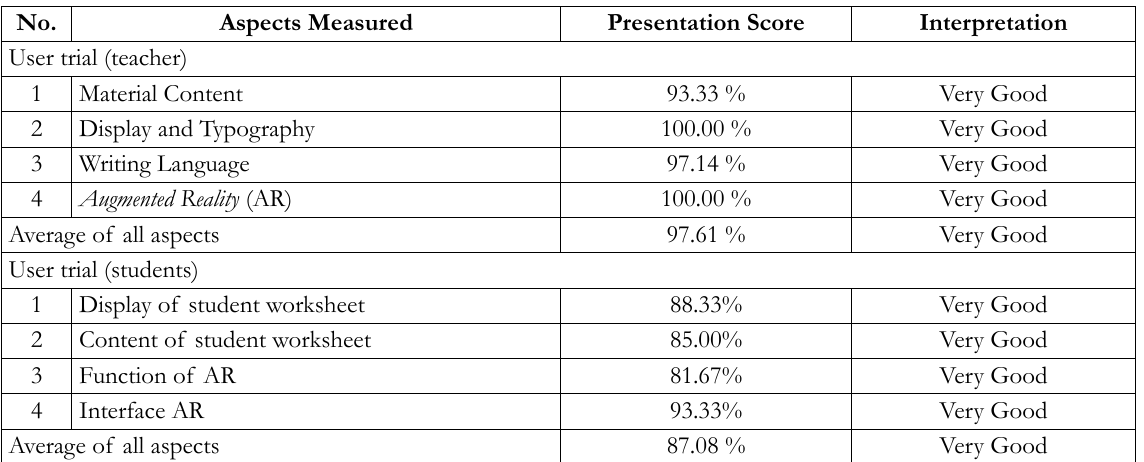
Table 4. User Trial Results (Teachers and